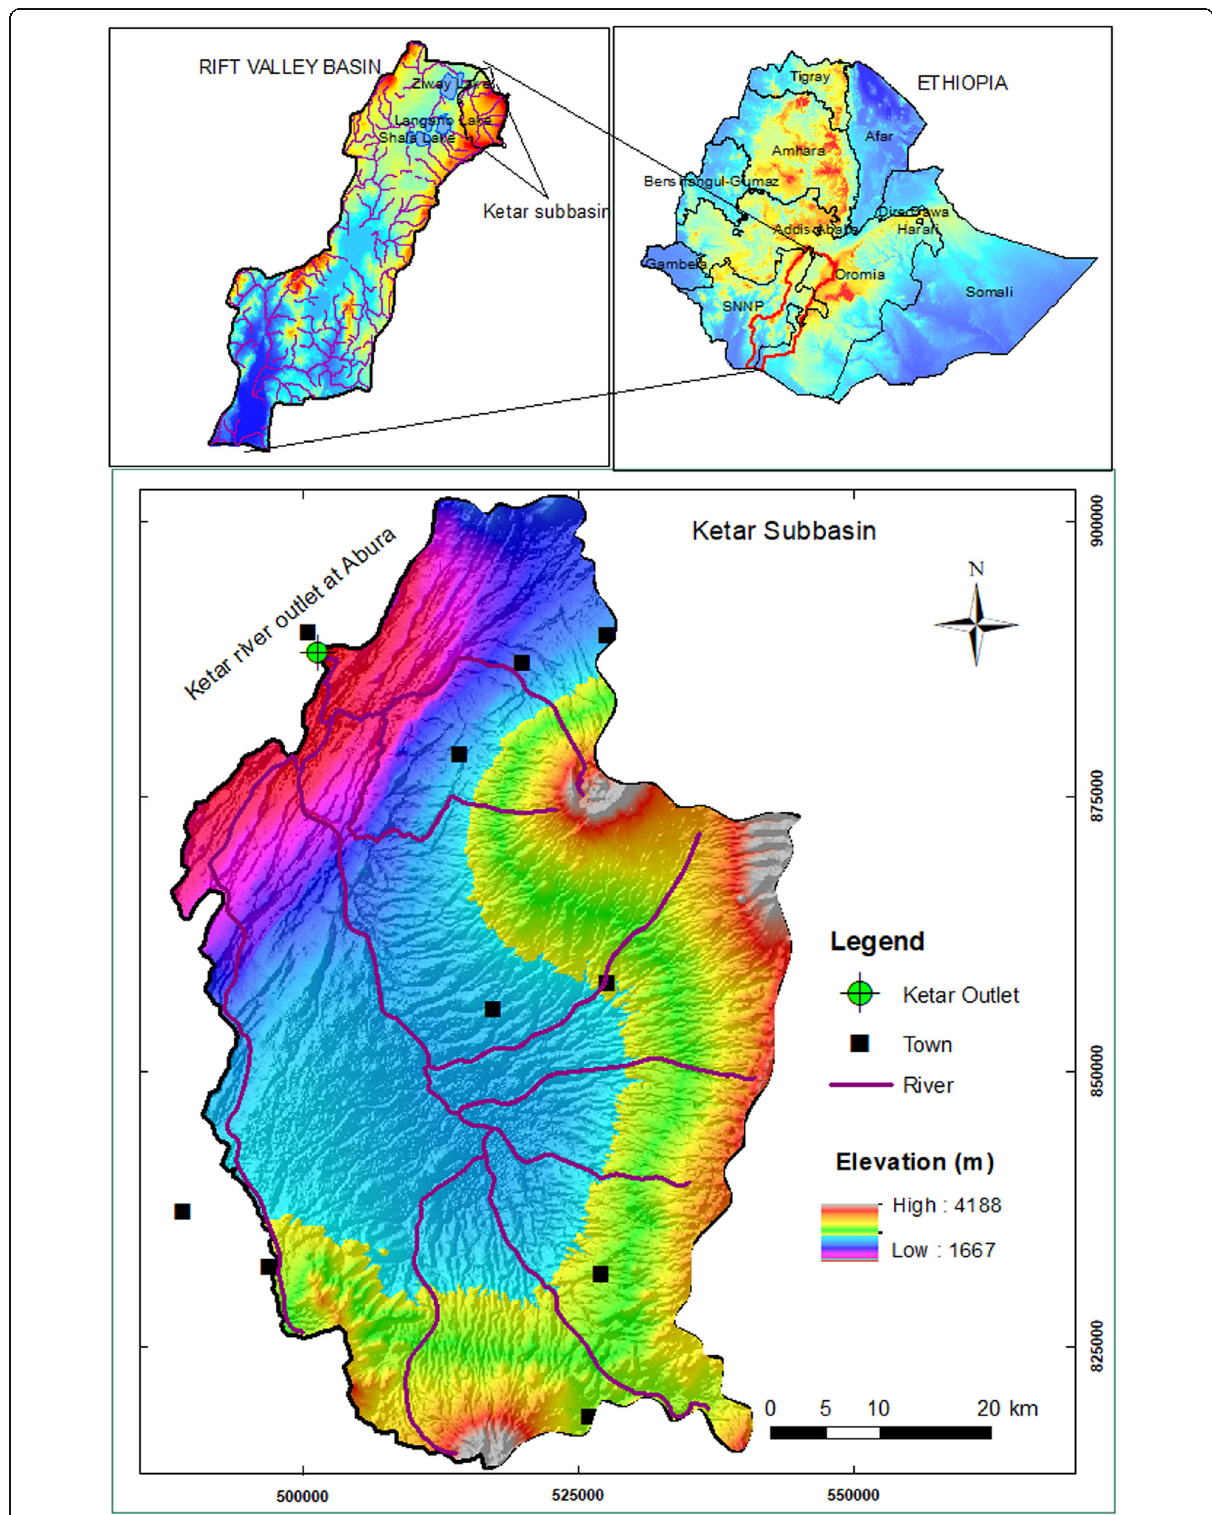
Fig. 1 Geographical location of the Ketar